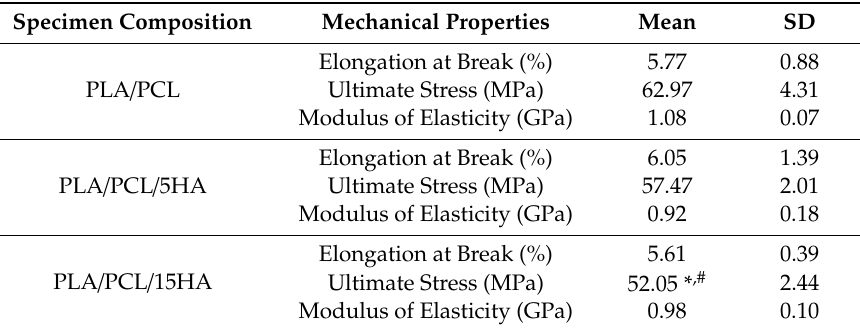
Table 6. Summary of the tensile testing results.